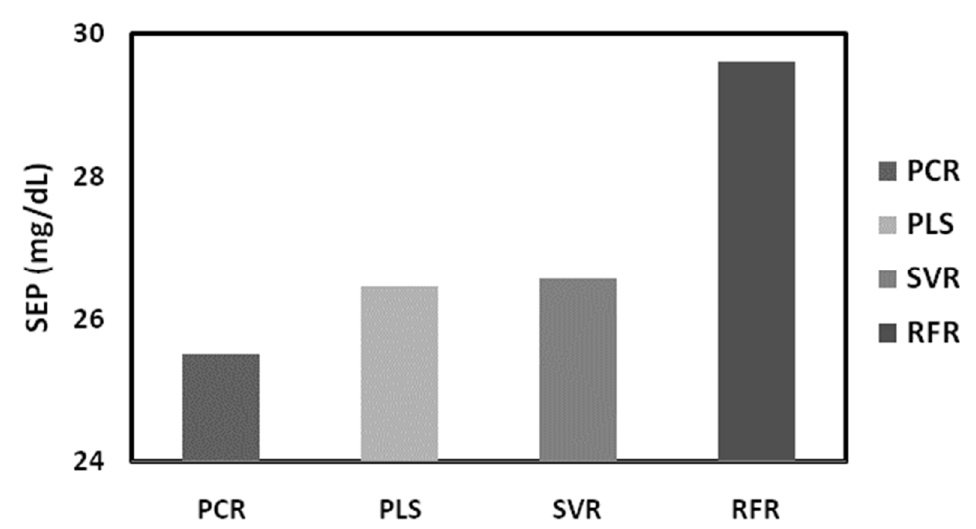
Figure 13. Comparison of performances of different regression techniques.